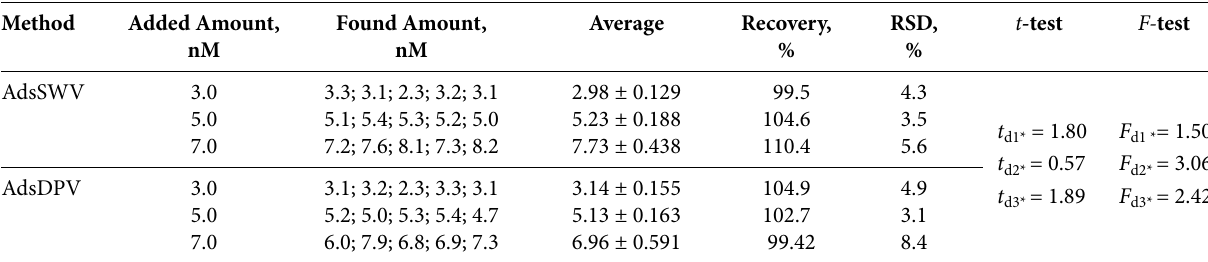
Table 3 . Recovery results for KC in pharmaceutical shampoo (n=5) Method